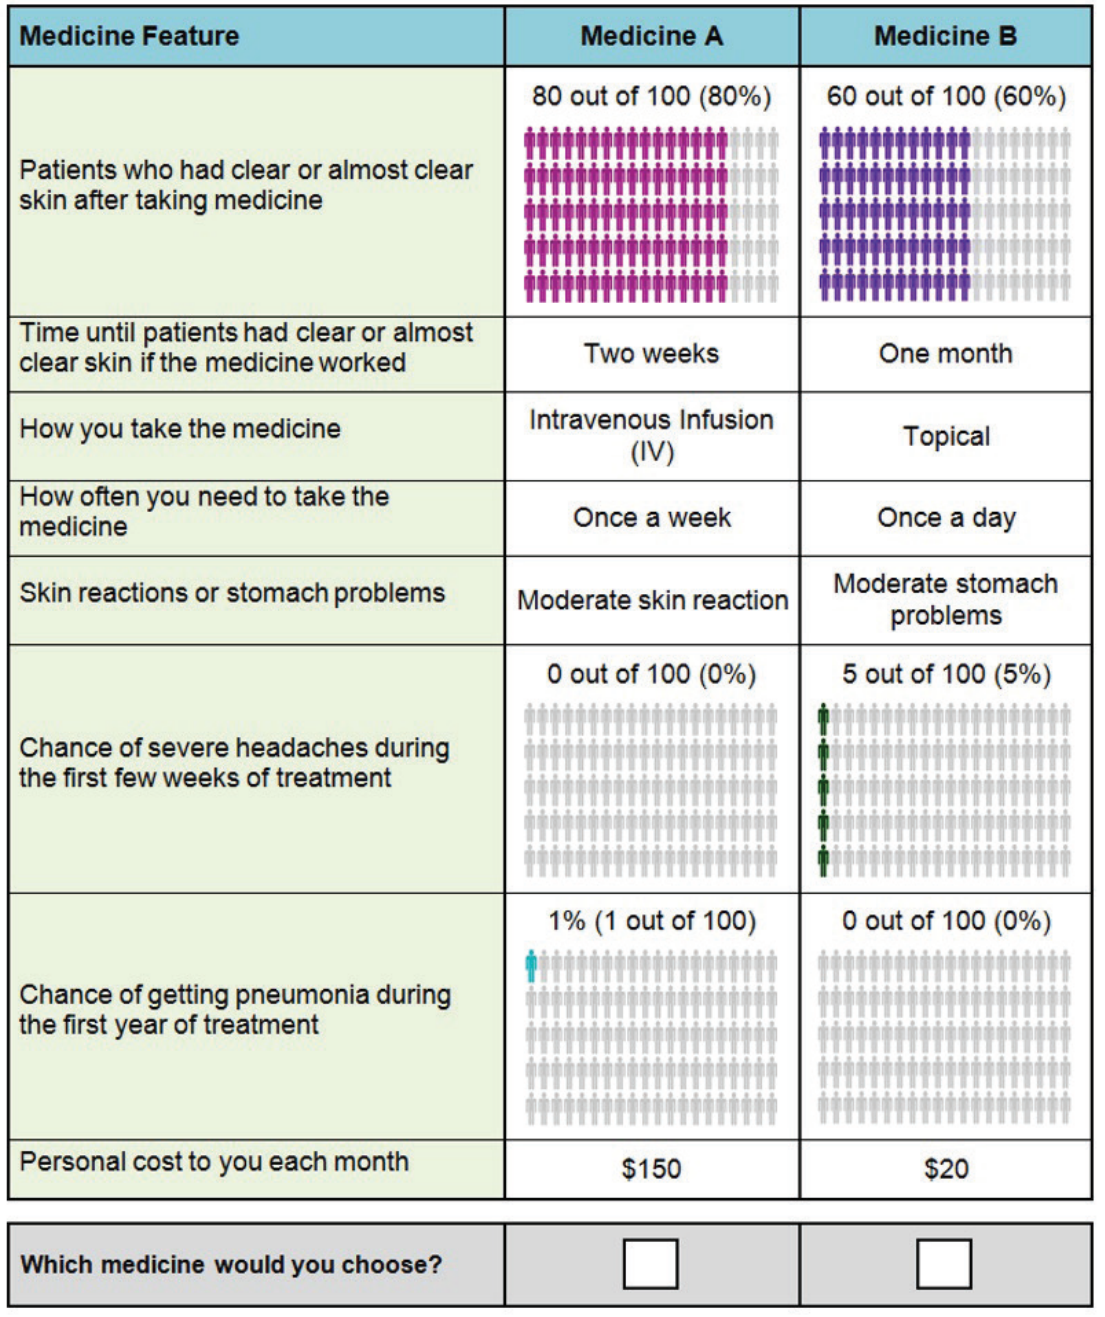
Figure 1. Example of the Treatment-Choice